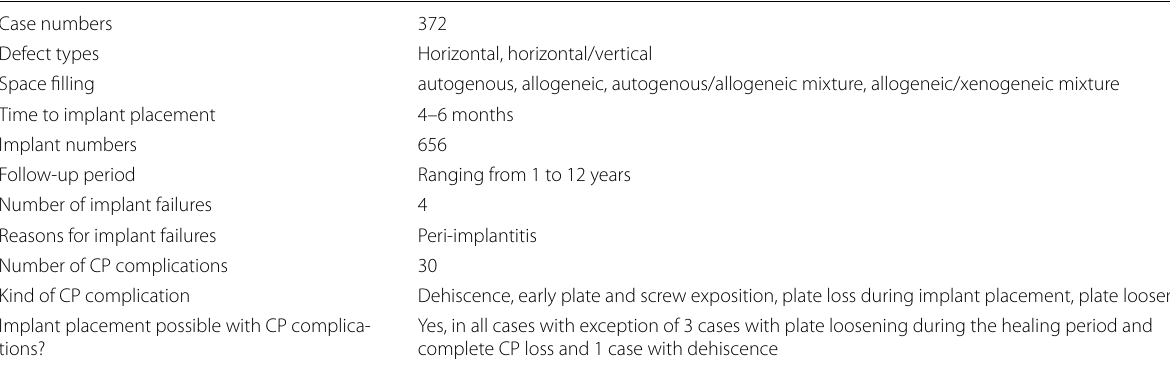
Table 1 Descriptive data concerning case numbers, defect types, the kind of space filling, CP complication rates and kinds of complications, number of inserted implants and implant failures, reasons for implant failure as well as the follow-up